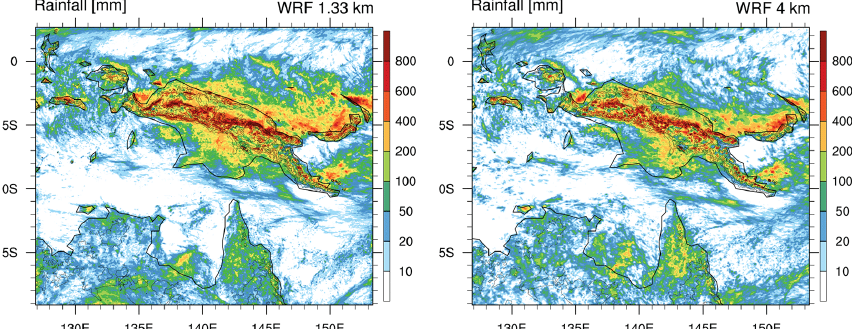
Figure 5. Two-week rainfall accumulations from the (a) 1.33km and (b) 4km free-running model simulations in domain 3 (d03) at their native grid